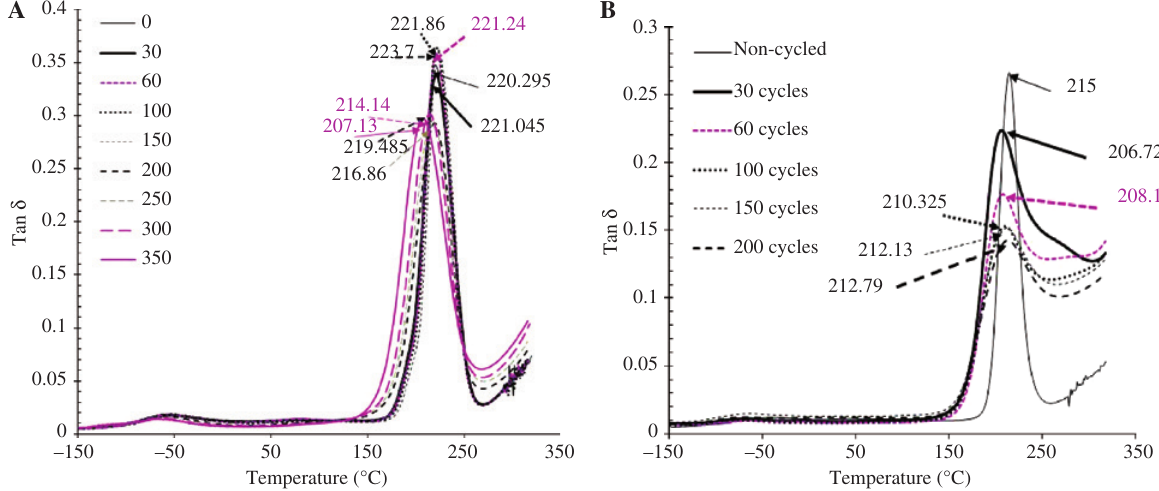
of (A) UD and (B) cross-ply fabric composites in the 90 ° direction. g